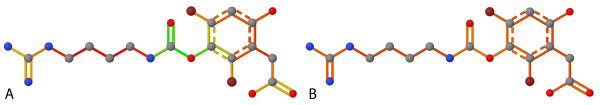
Clavatadine A. Clavatadine A colored according to a model trained on MUV846. The color gradient ranges from green (important for activity) to red (unimportant for activity). The current molecule normalization (A) and the full data set normalization (B) were both applied. The carbamate substructure is marked as important for activity.